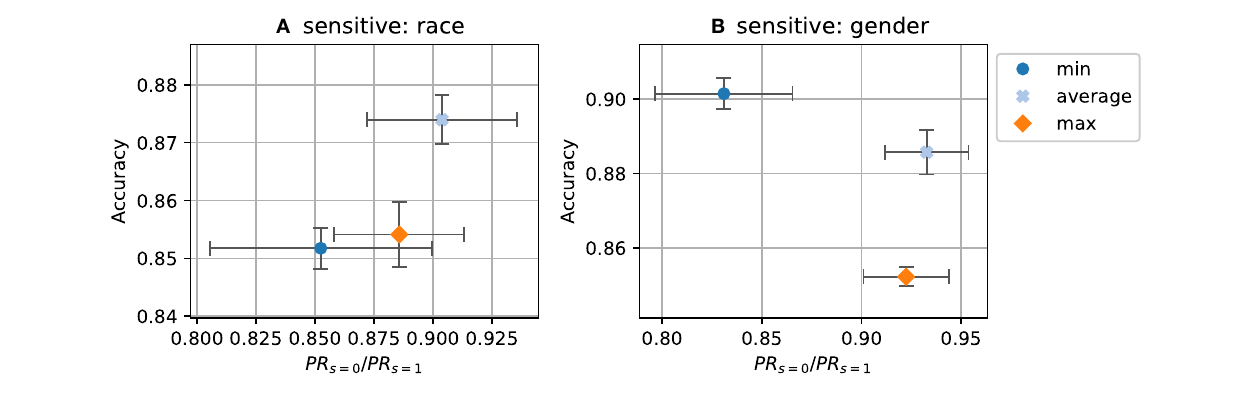
and FairLR are clearly fairer than the baseline GP and